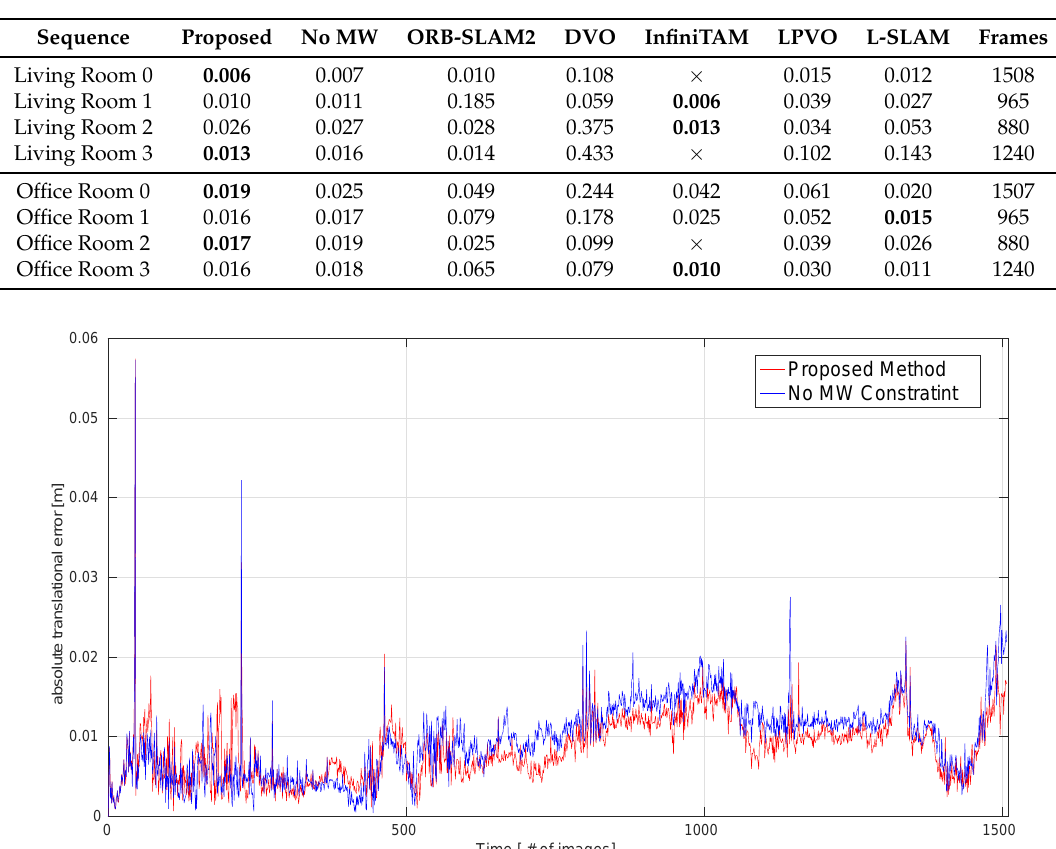
Table 1. Comparison of ATE.RMSE (unit: m) on the ICL-NUIM dataset. The smallest values are bolded, which indicates the most accurate method for the pose estimation.